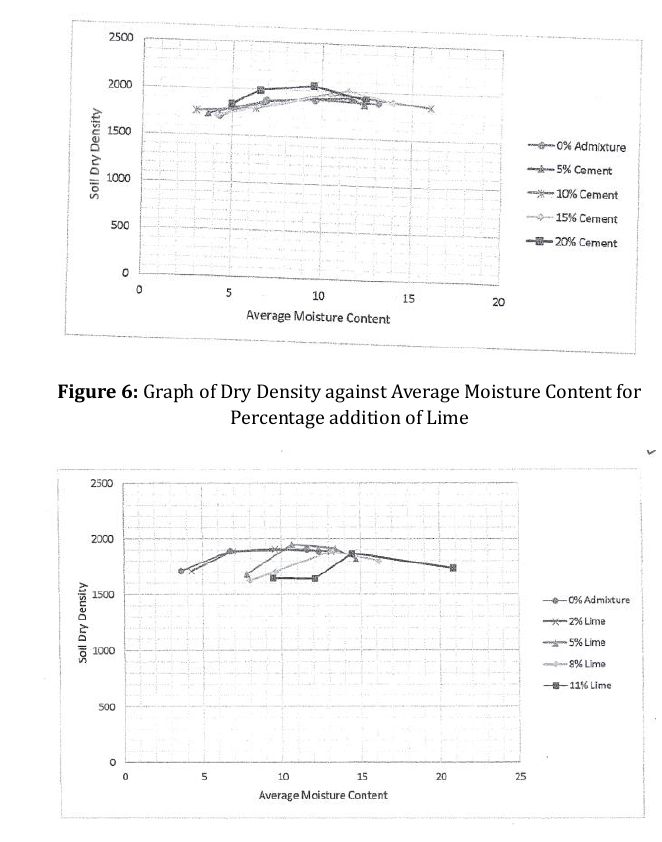
Figure 1: Particle Size Distribution Chart for Point 1